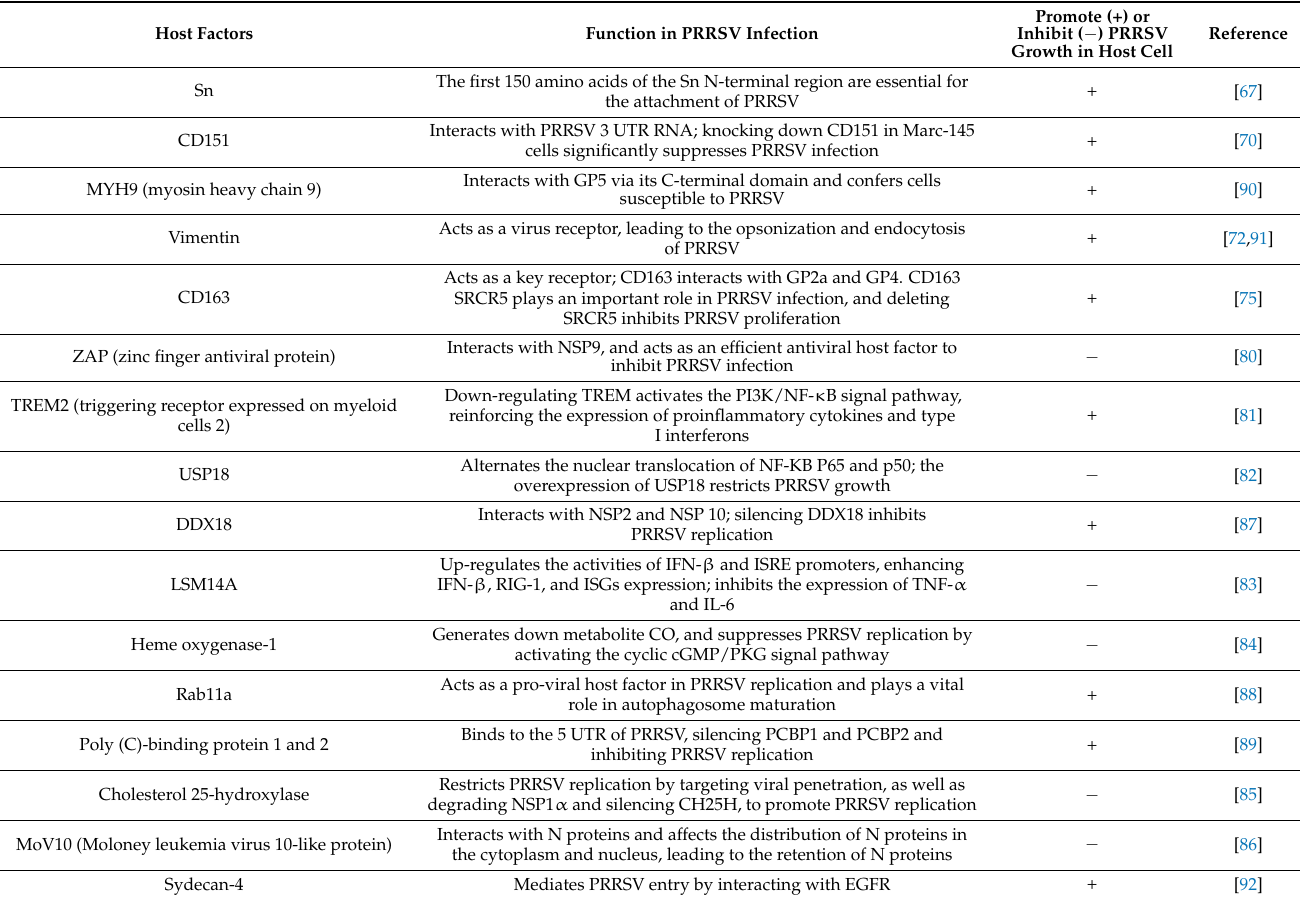
Table 3. Host factors that act in PRRSV